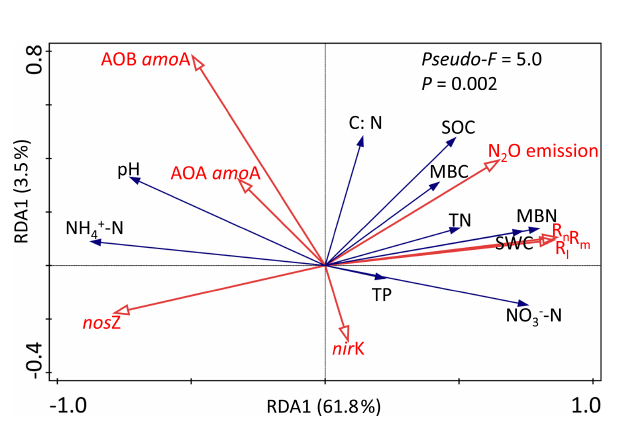
Figure 5. Redundancy analysis (RDA) among environmental vari- ables (NH + -N, NO − -N, pH, SOC, TN, C / N ratio and SWC), func- 4 3 tional genes (AOA amoA , AOB amoA , nirK and nosZ ) and soil N- transformation rates ( R m , R n , R l and N 2 O emission) in the wet season. Values on the axes indicate the percentages of total varia- tion explained by each axis.